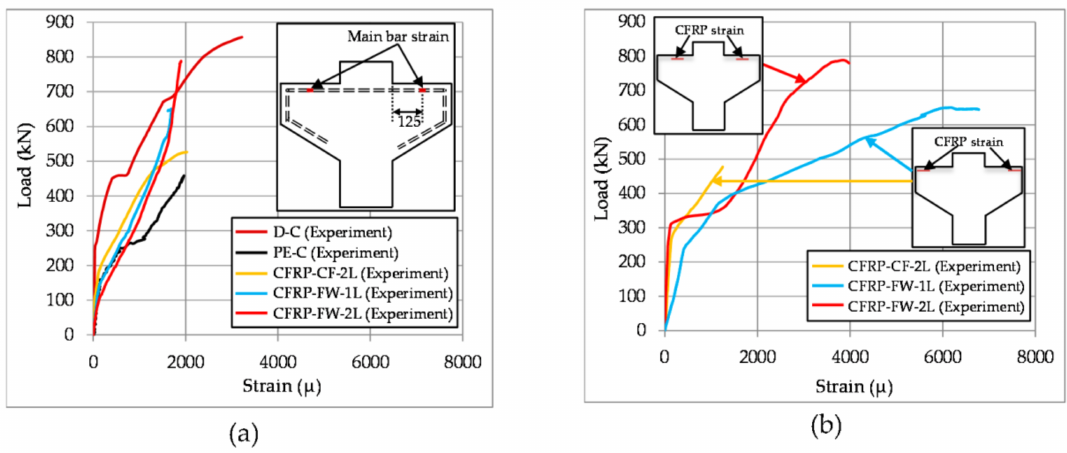
Figure 10. Load-strain relationships: ( a ) Main flexural steel bar and ( b ) CFRP